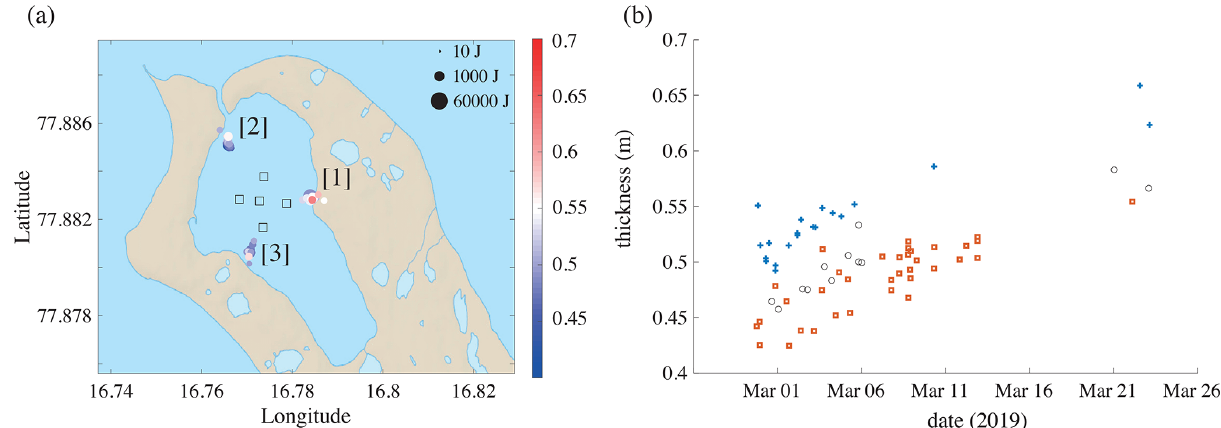
Figure 8. (a) Same as Fig. 7a, restricted to icequakes originating only from directions marked as [1], [2] and [3]. (b) Same as Fig. 7b, for the icequakes in the three groups shown in Fig. 8a: + for group [1], ◦ for group [2] and (cid:3) for group [3]. Inversions originating from the same region and at a similar date have a range of thicknesses that is consistent with the standard deviation of each individual inversion (i.e., 2.5cm). When comparing all directions, however, the range of thicknesses is on the order of